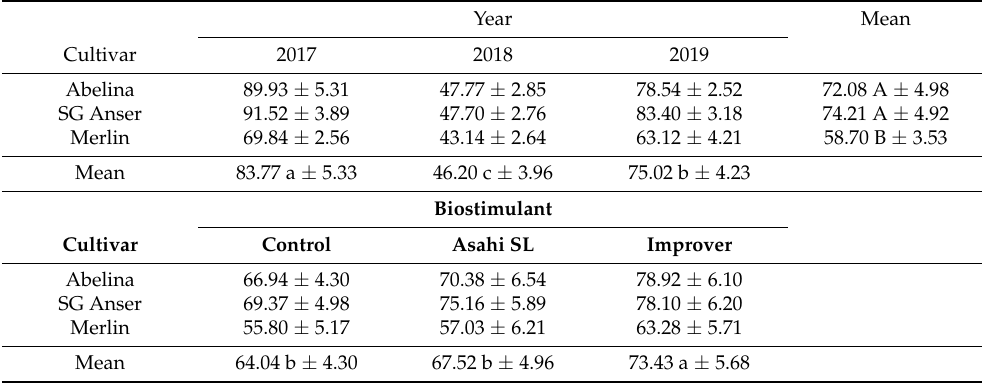
Means in rows followed by different letters in lowercase: a, b and c (for years and biostimulants) differ significantly at p ≤ 0.05. Means in columns followed by different letters in uppercase: A and B (for cultivars) differ significantly at p ≤ 0.05; ± Se (standard error)